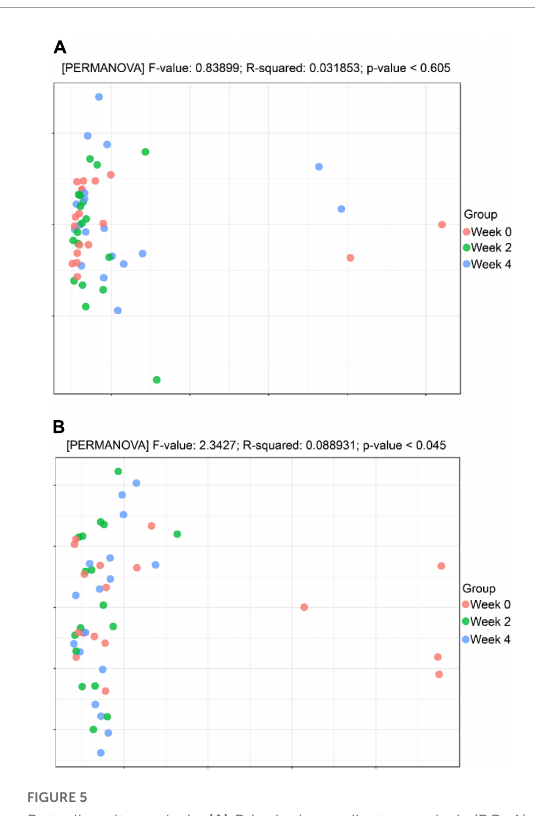
FIGURE5 Beta diversity analysis. (A) Principal coordinates analysis (PCoA) analysis in the probiotic (treatment) group. (B) PCoA analysis in the placebo (control) group. FIGURE6